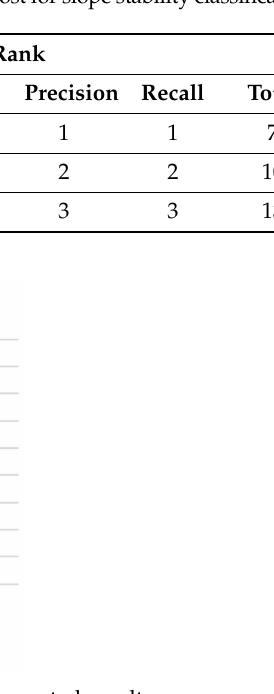
Table 7. Modelling results for the testing datasets of DT, RF, and AdaBoost for slope stability classification.